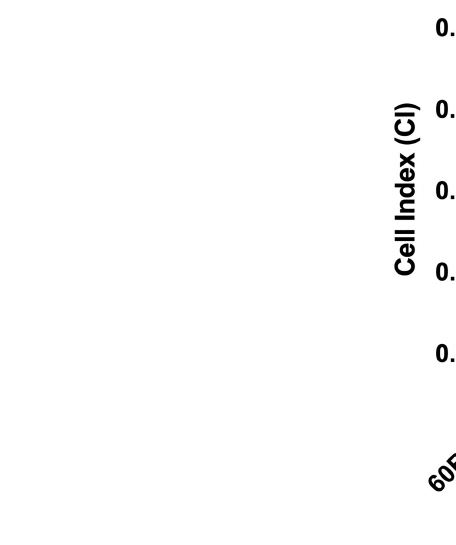
FIGURE 8 | Maximum bio fi lm formation by 60B and 60CSF. 60B and 60CSF were cultured overnight on BA plates before being diluted to a fi nal OD 600 of 0.05 in CDM + 0.5% glucose or CDM + 0.5% galactose. 200 µL of each bacterial strain in each sugar was placed into wells of a xCELLigence E-plate, with the plate being placed in the cradles of the RTCA-DP platform, and incubated at 37°C. Bio fi lm formation was determined by measuring cell index (CI) every 15 min over 24 h using real-time cell analysis (RTCA) xCELLigence technology. Data are mean maximum CI ± standard error mean (SEM) from three independent assays, each performed in triplicate. Statistical analysis was performed using two-tailed Student ’ s t test. No signi fi cant differences were detected between the bio fi lm formation of the strains in different carbon